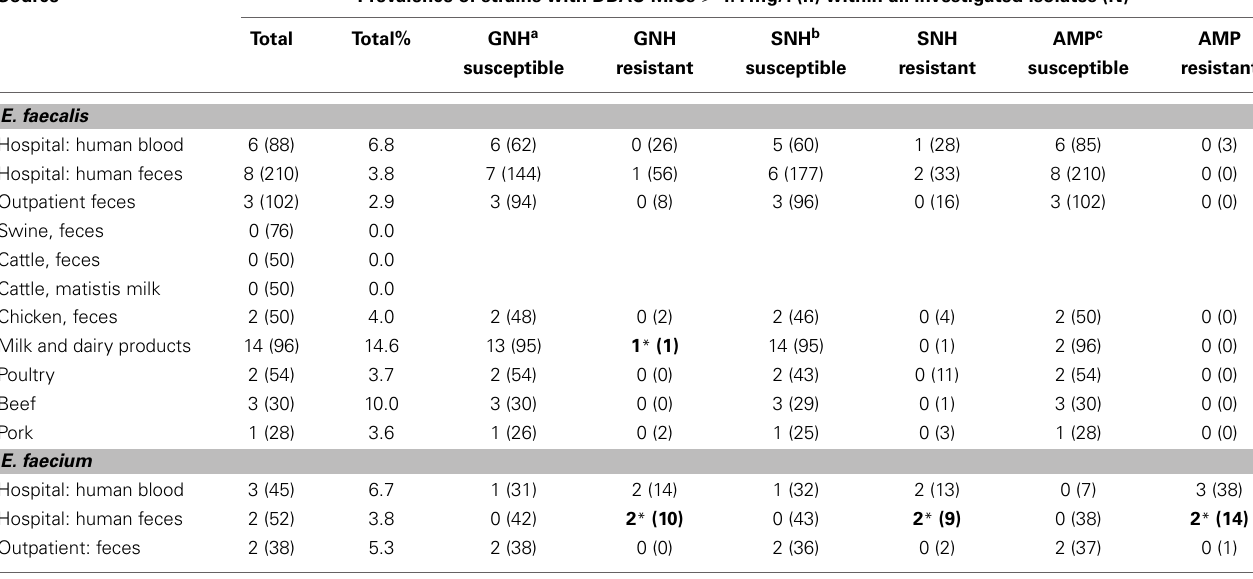
Table 2 | Prevalence of E. faecalis and E. faecium with DDAC-MICs > 1.4 mg/l within antimicrobial-susceptible and –resistant isolates of different